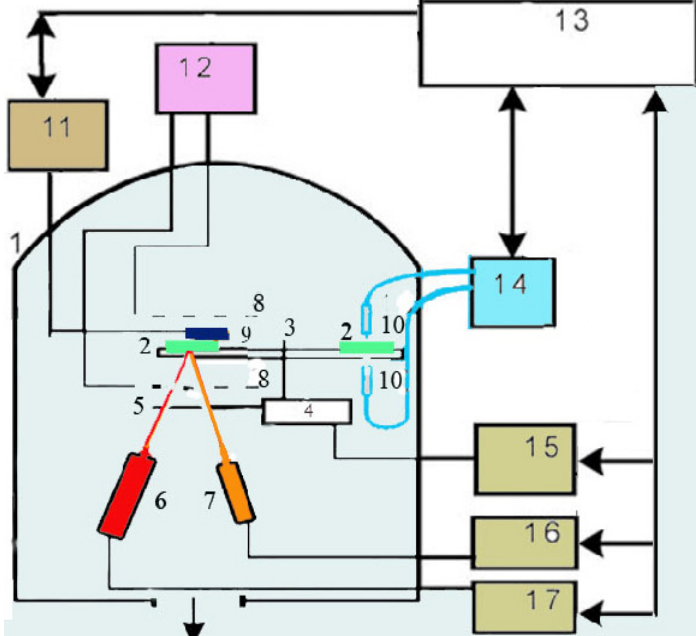
Figure 1. Setup of the deposition installation: (1) vacuum chamber; (2) substrates; (3) system and (4) motor for substrate rotation; (5) shutter; (6) evaporator-activator for polytetrafluoroethylene (PTFE); (7) evaporator for Au; (8) RF electrodes; (9) quartz crystals of Sigma card; (10) fibres; (11,15–17) controllers of quartz monitors, motor, PTFE and Au evaporators; (12) RF generator; (13) computer; (14) optical spectrometer